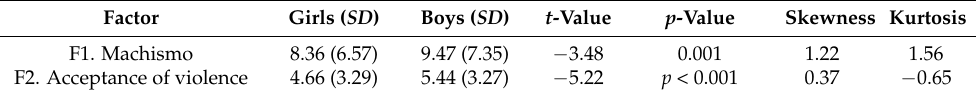
Table 2. The means and standard deviations of the scores of the MVQ scale factors and t-test differences between girls and boys and the skewness and kurtosis for the